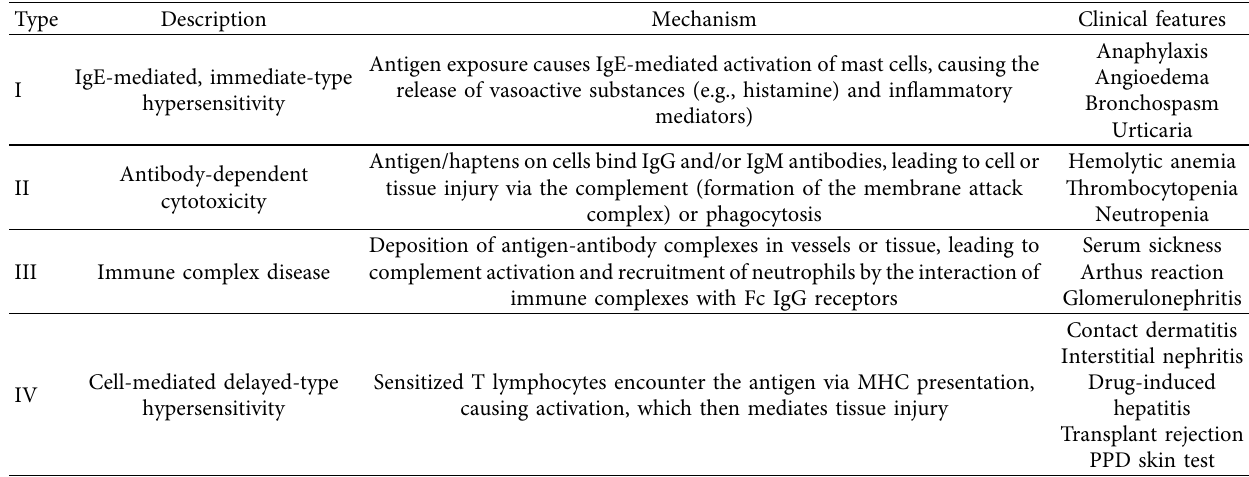
Table 1: Gell and Coombs classification of hypersensitivity reactions distinguishes four types of immune responses [7, 13]. Type